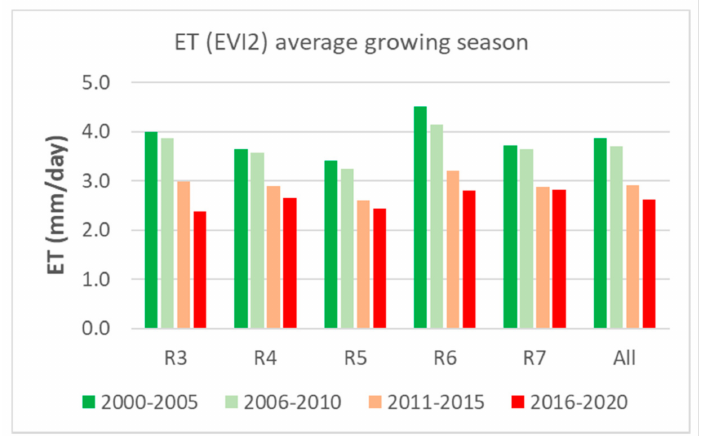
Figure 9. ET (mmd − 1 ) averaged across four groups of years in ~5-year periods (2000–2005 = green, 2006–2010 = light green, 2011–2015 = peach, 2016–2020 = red) for five reaches and the weighted average of All reaches along the Lower Colorado